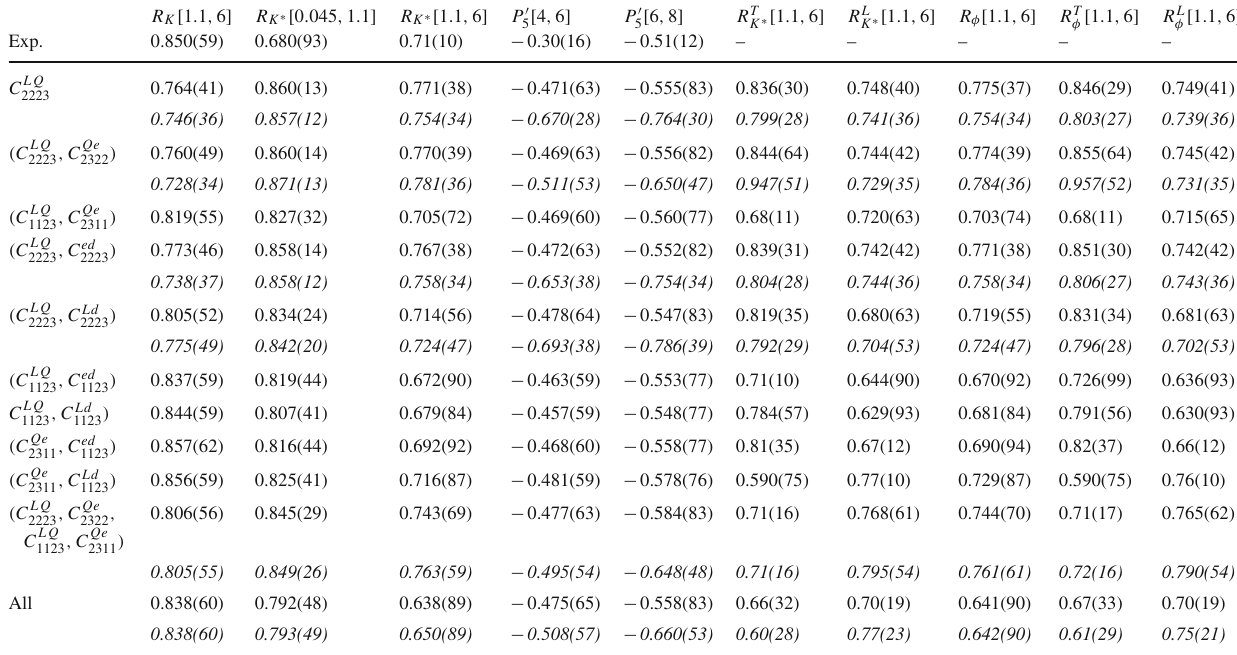
Table 4 Experimental measurements with symmetrized errors (for R K ∗ and P (cid:4) we report the LHCb ones) and results from the fit for 5 key observables in the SMEFT scenarios considered here. The italic